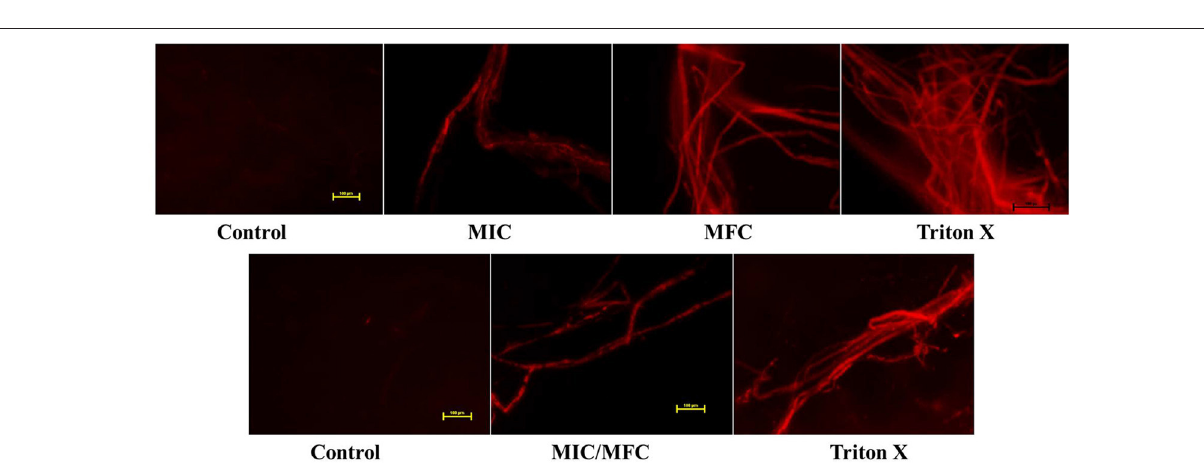
This indicates that CHG can produce its growth inhibitory and the